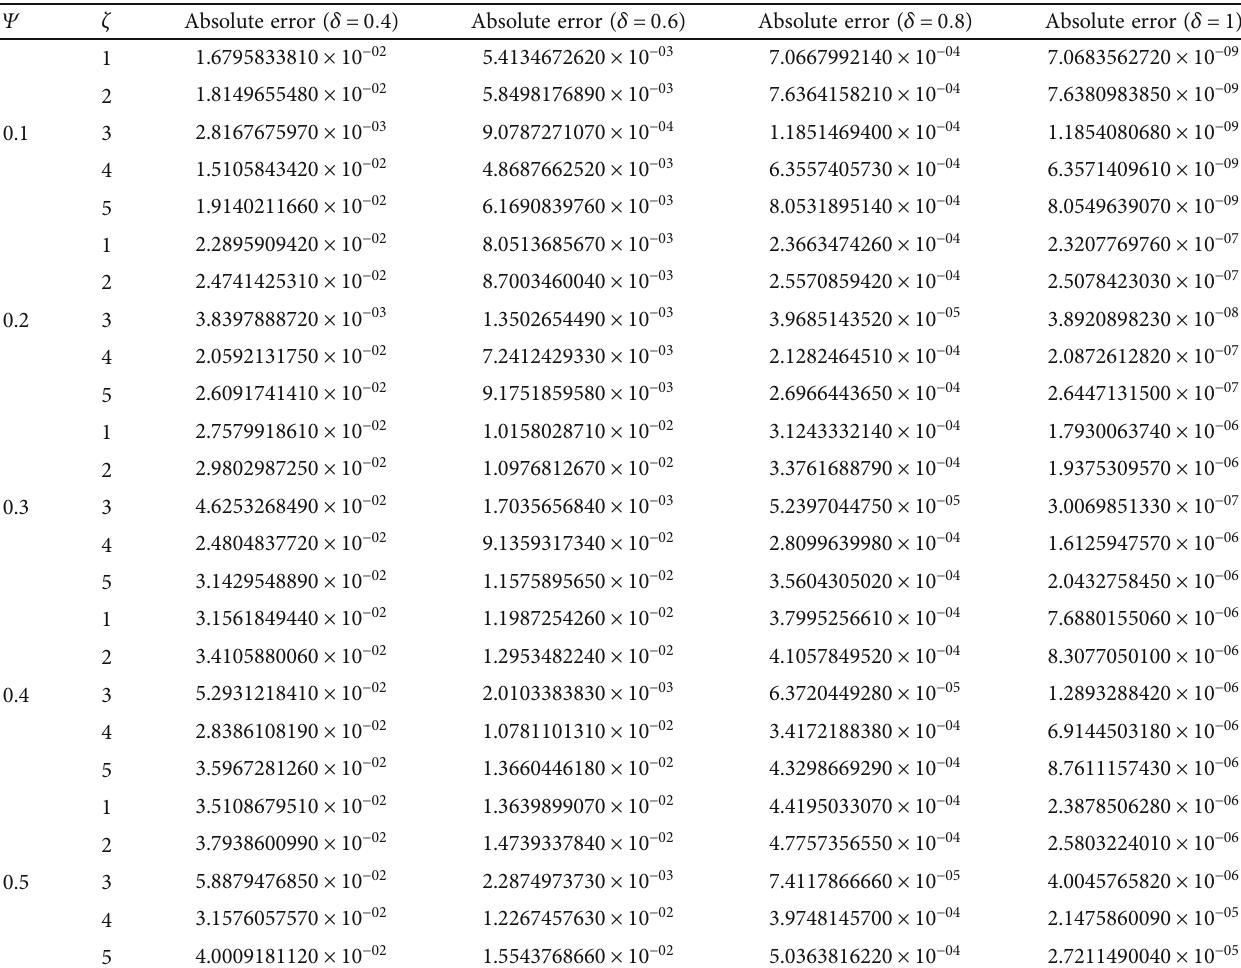
Figure 6: The YDM solution of example 1 of ν ð ζ , Ψ Þ at δ = 1 , and 0 : 8 . Table 1: YDM-solutions of example 1 μ ð ζ , Ψ Þ and ν ð ζ , Ψ Þ di ff erent fractional-order of δ